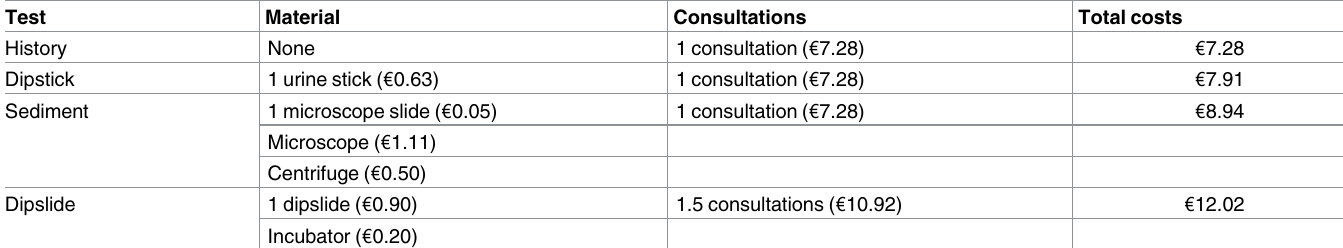
Table 2. Total costs for each test (history questions, dipstick, sediment and dipslide), subdivided into costs per test